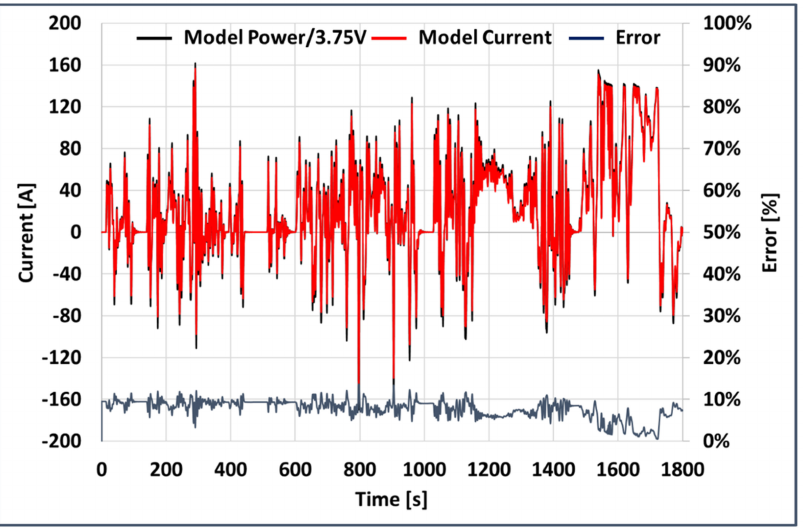
Figure 4. Battery current computed as the ration of power on rated voltage and error.